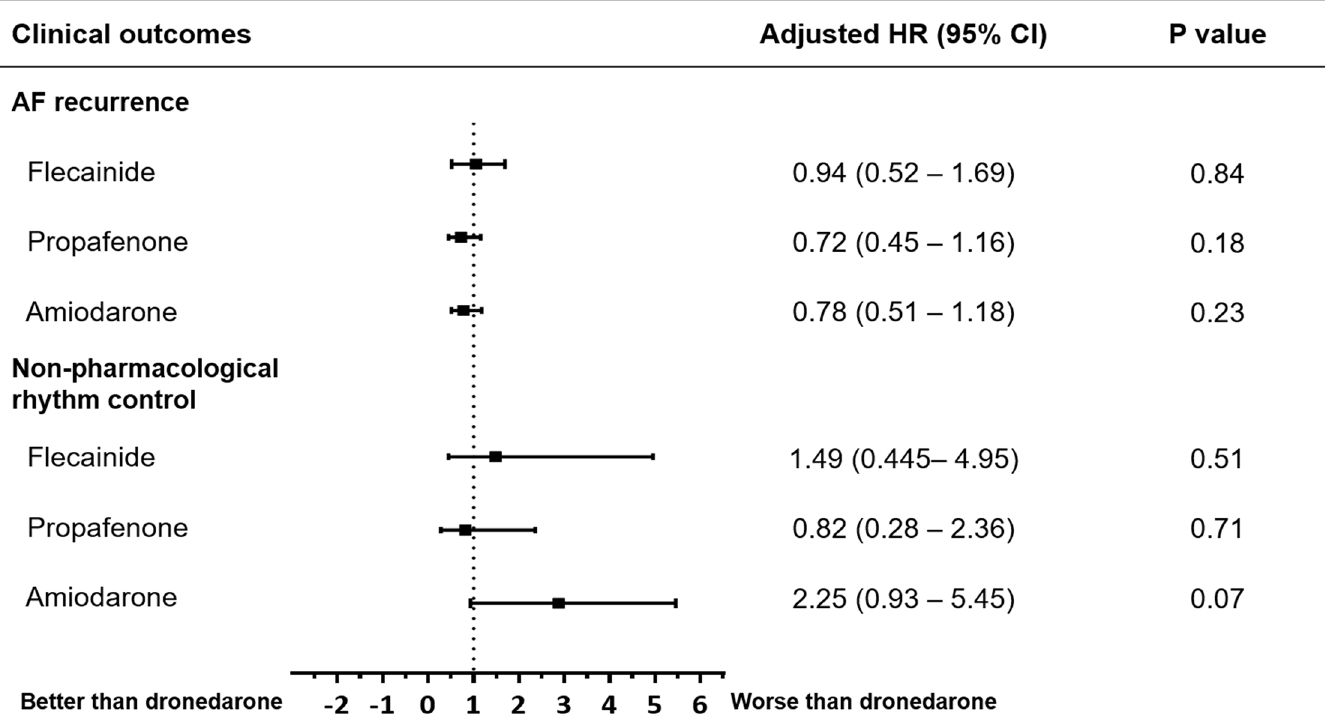
Fig 3. Cox proportional hazards model for atrial fibrillation recurrence and additional rhythm control. The dronedarone group was used as a reference group. Adjusted covariates included sex, cardiomyopathy, chronic obstructive lung disease, coronary artery disease, beta-blocker use, and left atrial volume index. AF indicates atrial fibrillation; CI, confidence interval; HR, hazard